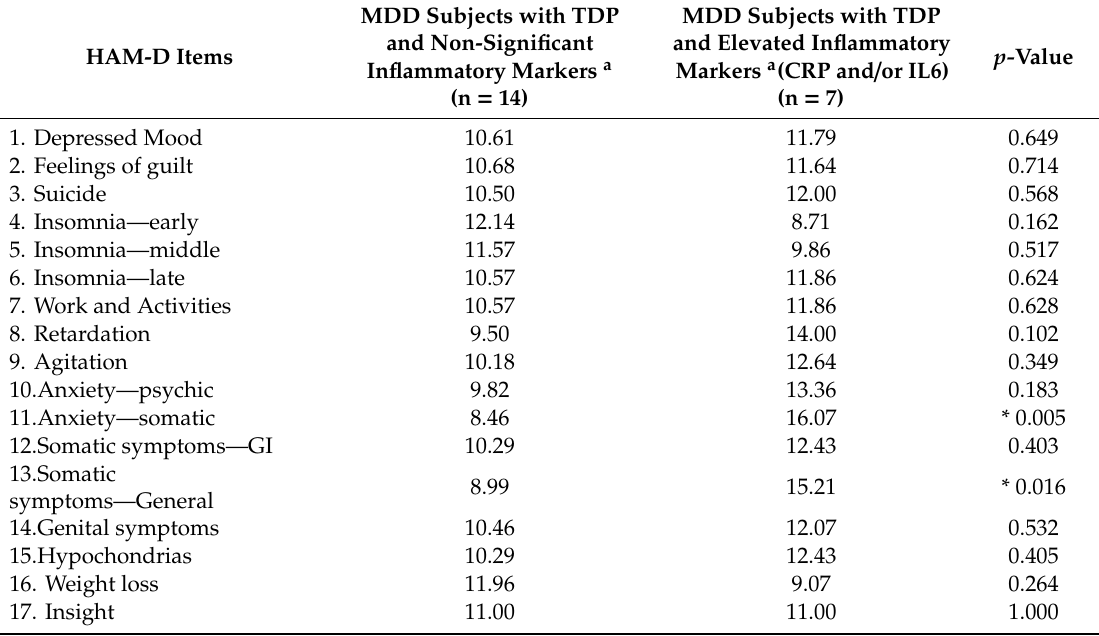
Table 2. Depressive symptoms profile depending on the presence or absence of peripheral inflammatory markers (in comparison with subjects with normal blood levels) in MDD patients with type D personality